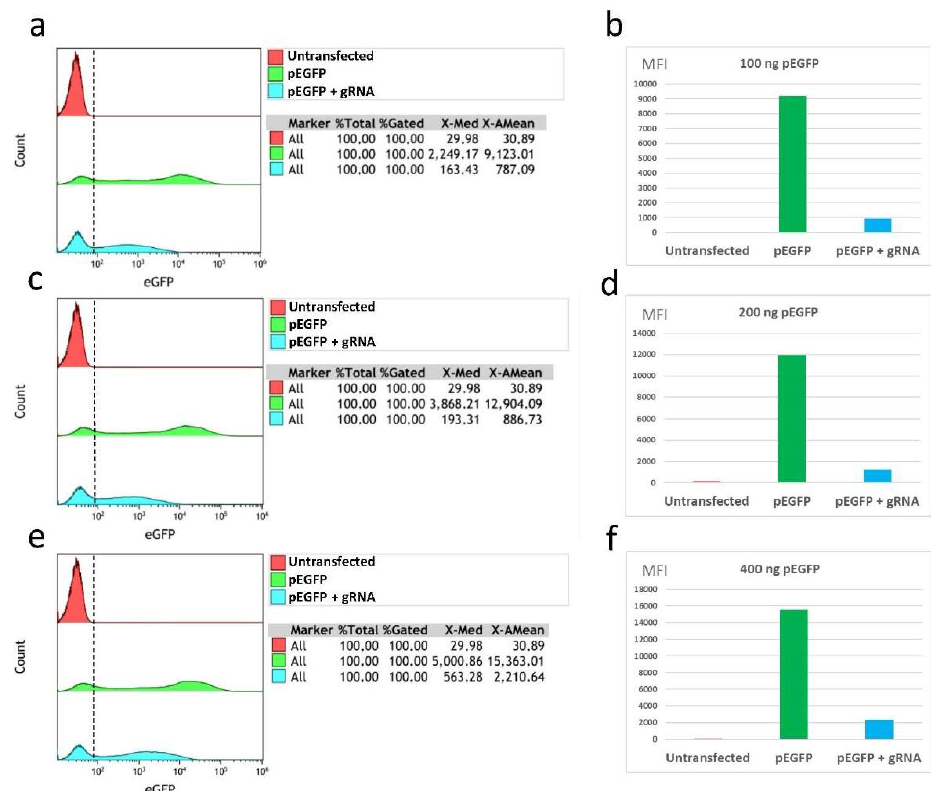
Figure 3. Histograms for total cell populations of each condition: ( a ) condition 100; ( c ) condition 200; ( e ) condition 400. The mean of the MFI triplicated values represented for each condition: ( b ) condition 100; ( d ) condition 200; and ( f ) condition 400. For each condition, a graph with three histograms is represented. Each histogram represents two different cell populations: the population to the left of the discontinued line corresponds to cells without fluorescence, and the rest of the population corresponds to cells that presented eGFP fluorescence. From top to bottom: untransfected cells (red); control situation transfected cells (green); and case situation transfected cells (blue) are represented in each histogram (identified in the upper box of each graph). The mean fluorescence intensity (MFI) was calculated using the arithmetic mean of eGFP fluorescence and represented using the mean of the values obtained in each triplicate. The graphs in this image are downloaded from Kaluza